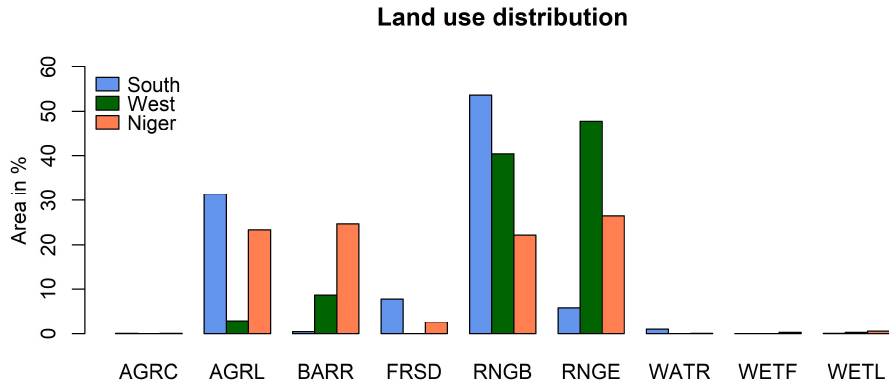
Figure 2. Final SWAT Land Use Distribution for each Model, where AGRC: close grown agriculture; AGRL: agriculture; BARR: barren; FRSD: forest deciduous; RNGB: range brush; RNGE: range grasses; WATR: water; WETF: wetlands forested; WETL: wetlands.